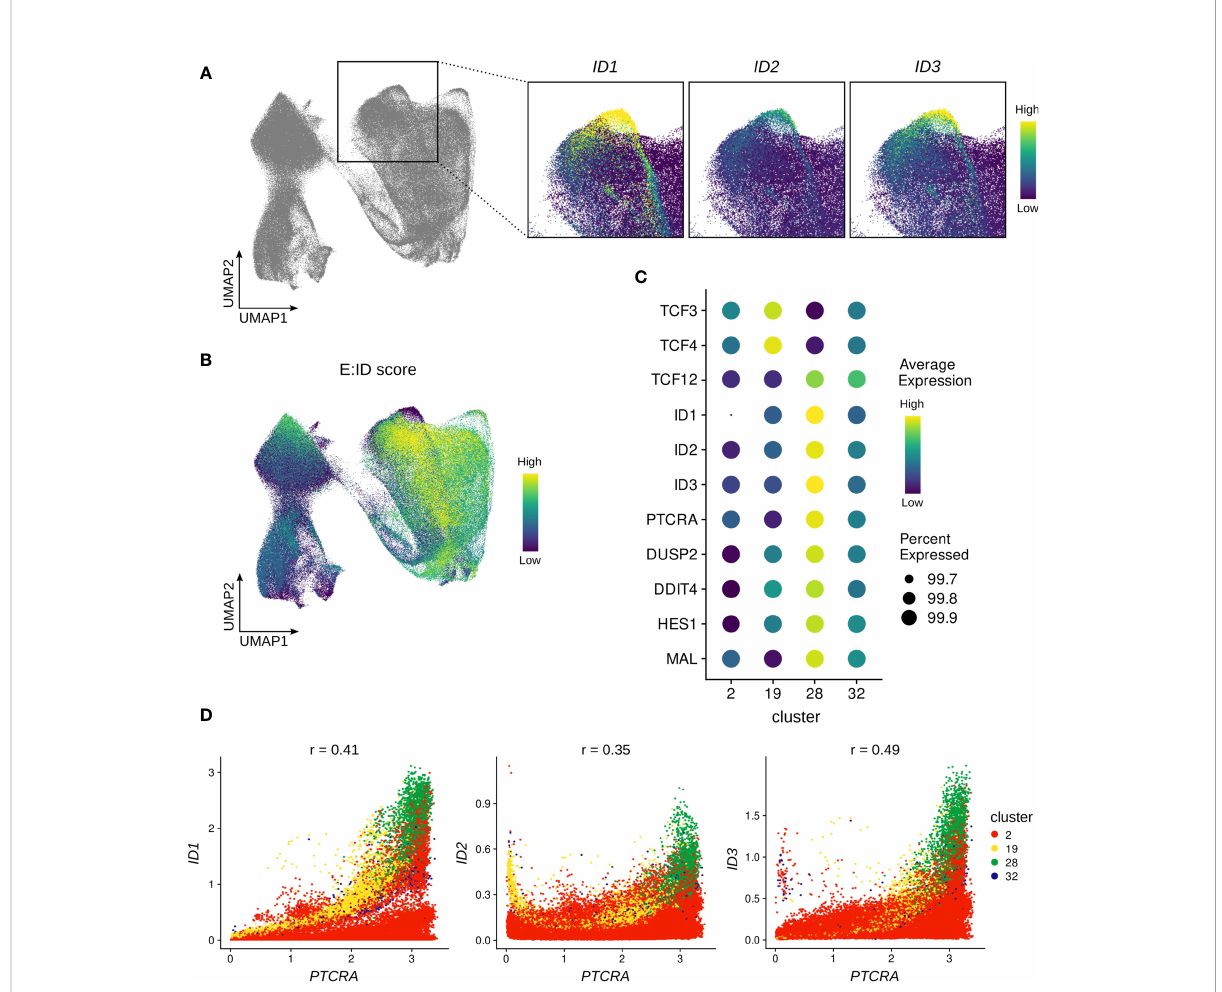
FIGURE 7 ID protein encoding genes are strongly induced in a subset of b -selecting thymocytes. (A) UMAP visualization of ID protein encoding gene expression in the b -selecting thymocyte cluster. (B) UMAP visualization of the E:ID score calculated on a per-cell basis. (C) Dot plot visualizing pseudo-bulk expression of E and ID protein encoding genes and cluster 28 marker genes. Imputed, gene-scaled expression is shown for all subclusters comprising the beta-selecting cluster. (D) Scatter plot for imputed transcript levels of ID protein encoding genes and PTCRA in b - selecting thymocytes. Cells are colored by b -selecting subcluster and Pearson correlation coef fi cient is